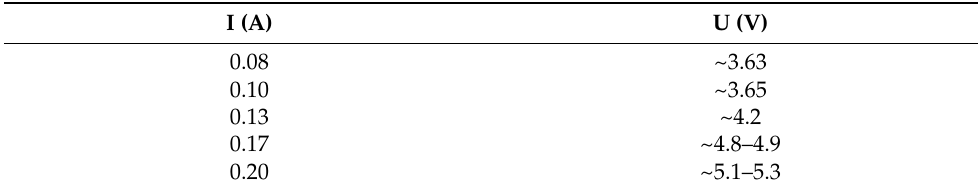
Table 1. Corresponding values of voltage when current was held constant.